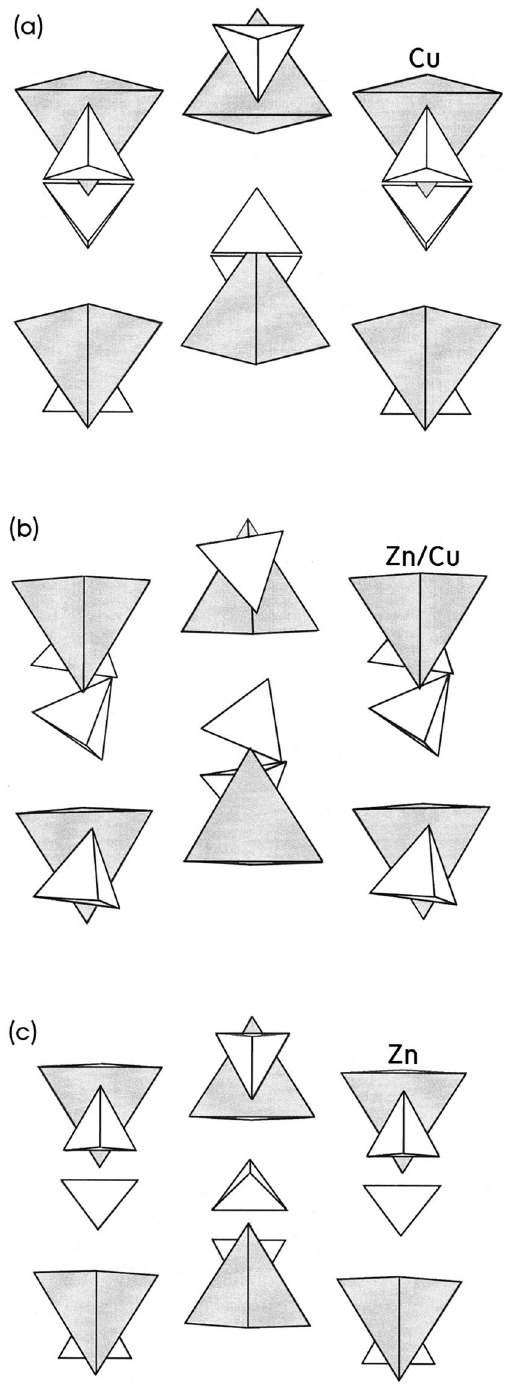
Figure 1. Structure of [N(CH 3 ) 4 ] 2 Zn 1- x Cu x Br 4 on the bc plane. Cu/ZnBr 42 − anions are represented by gray tetrahedrons. N(CH 3 ) 4 + cations are represented by empty tetrahedrons. ( a ) [N(CH 3 ) 4 ] 2 ZnBr 4 , ( b ) [N(CH 3 ) 4 ] 2 Zn 0.5 Cu 0.5 Br 4 , and ( c ) N(CH 3 ) 4 ] 2 CuBr